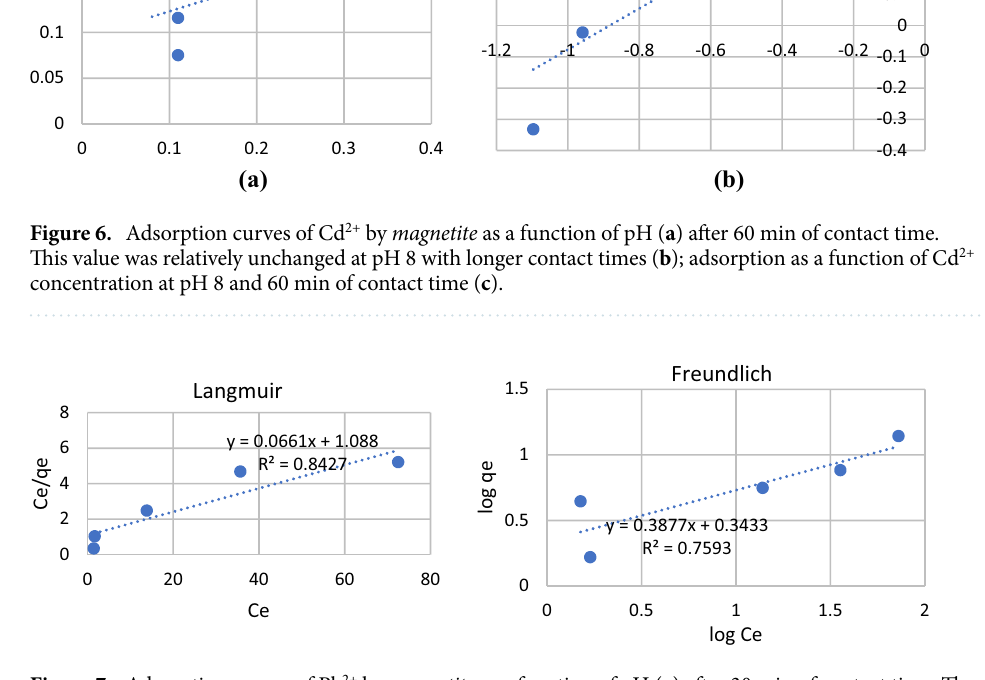
Figure 7. Adsorption curves of Pb 2+ by magnetite as a function of pH ( a ) after 30 min of contact time. The adsorption was relatively unchanged at pH < 7 with longer contact times ( b ). Adsorption efficiency as a function of Pb 2+ concentration at pH < 7 and 30 min contact time ( c ).